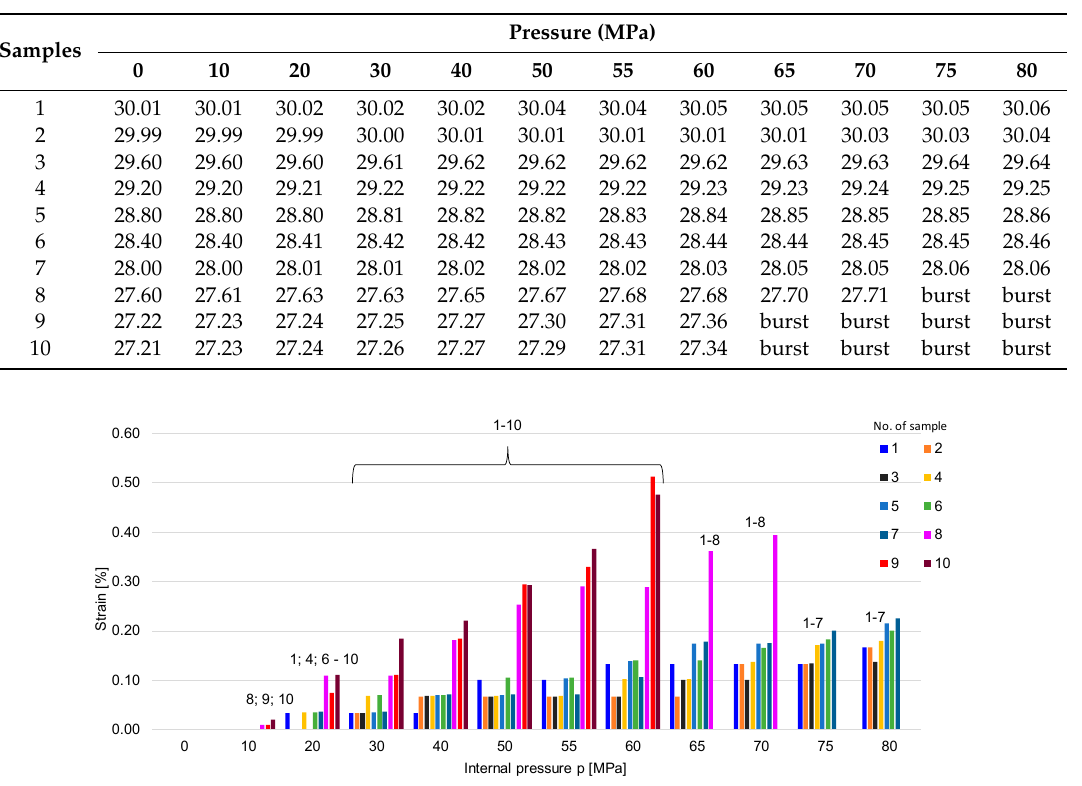
Table 3. The measured values of exterior diameter.